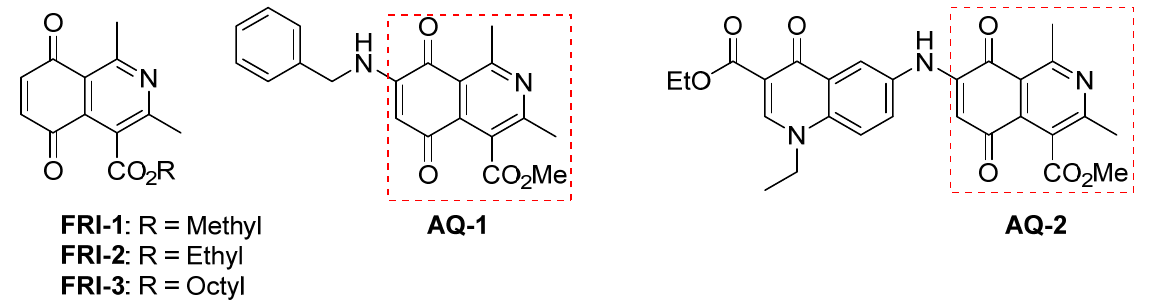
Figure 1. Chemical structures of isoquinolinequinones with biological effects reported.